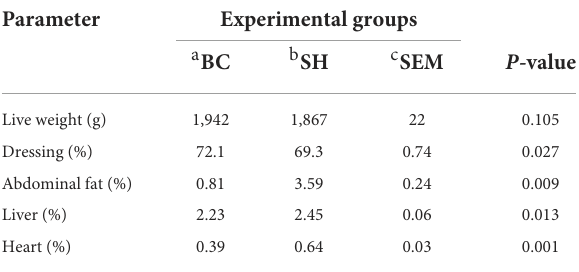
TABLE 2 Carcass traits of broiler chickens and spent laying hens.